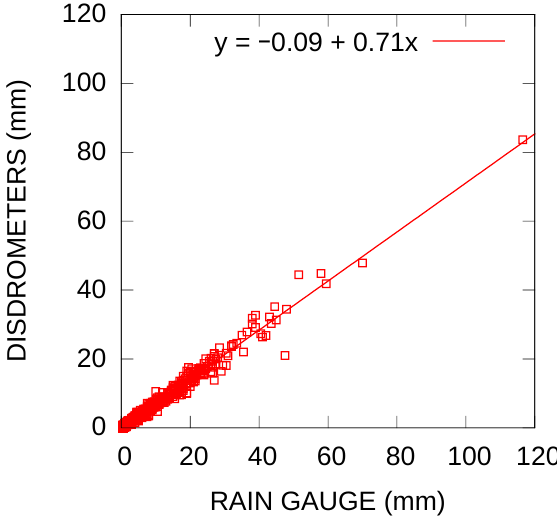
Figure 2. Comparison of hourly rainfalls between Parsivel 2 and tipping-bucket raingauge. The total number of samples is 959, which at least one tipping (0.5 mm) was recorded by the rain gauge, and data also includes more than 50 one-minute samples with good sensor status (0 or